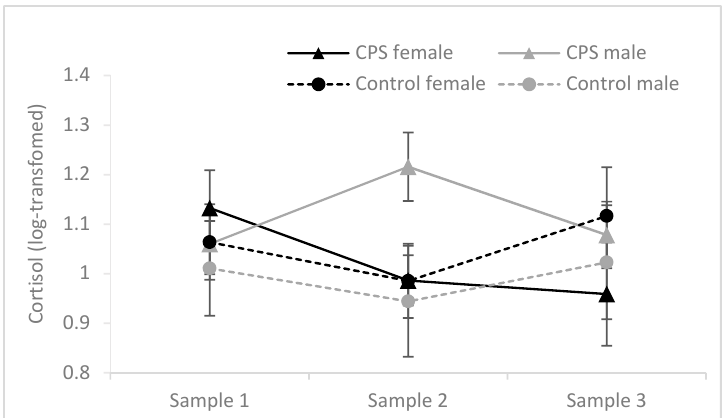
Figure 3. Salivary cortisol before encoding (Sample 1), after the stress/control manipulation (Sample 2) and before the final test in Session 2 (Sample 3) in males and females. Log-transformed cortisol values (original units: nmol/L) are shown. Error bars represent standard errors of means.